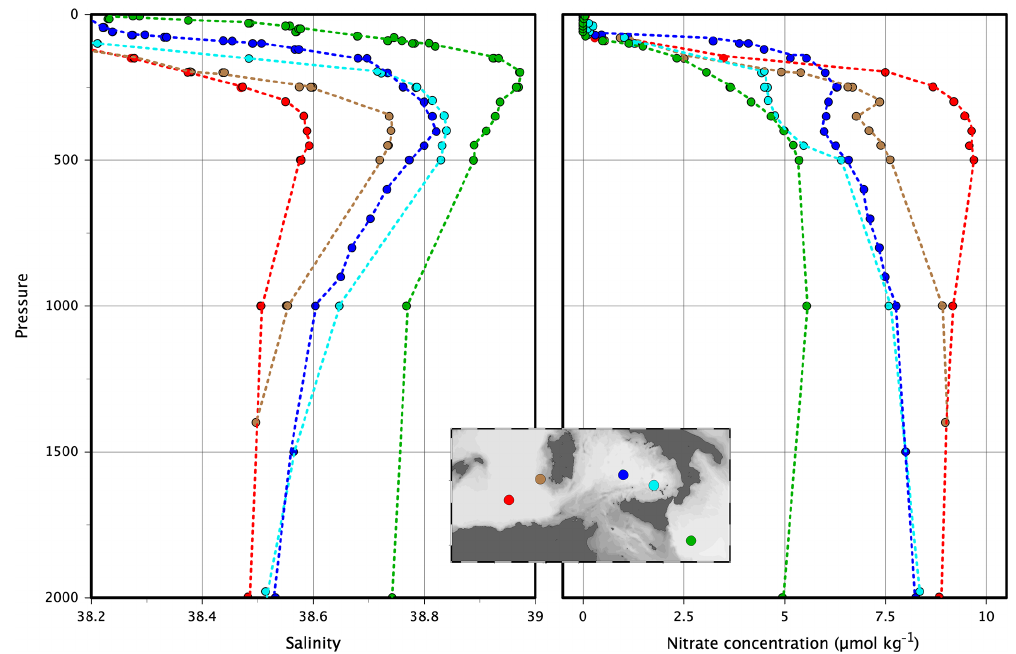
Figure 13. Discrete profiles of salinity and nitrate (µmolkg − 1 ) measured during the cruise PEACETIME. The station in the central Tyrrhe- nian Sea (dark blue dots) corresponds to cast A reported in Fig. 3. The station in the Algerian Basin (red dots) corresponds to cast H reported in Fig. 7.